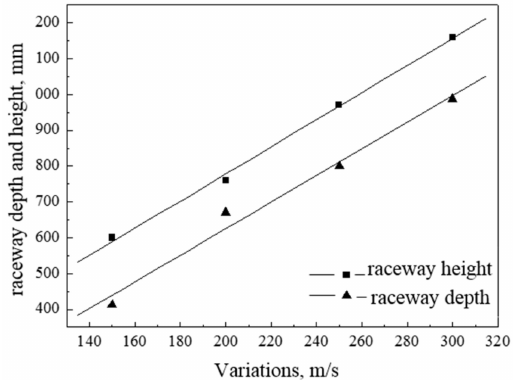
Figure 8. Variations of raceway depth and height with blowing